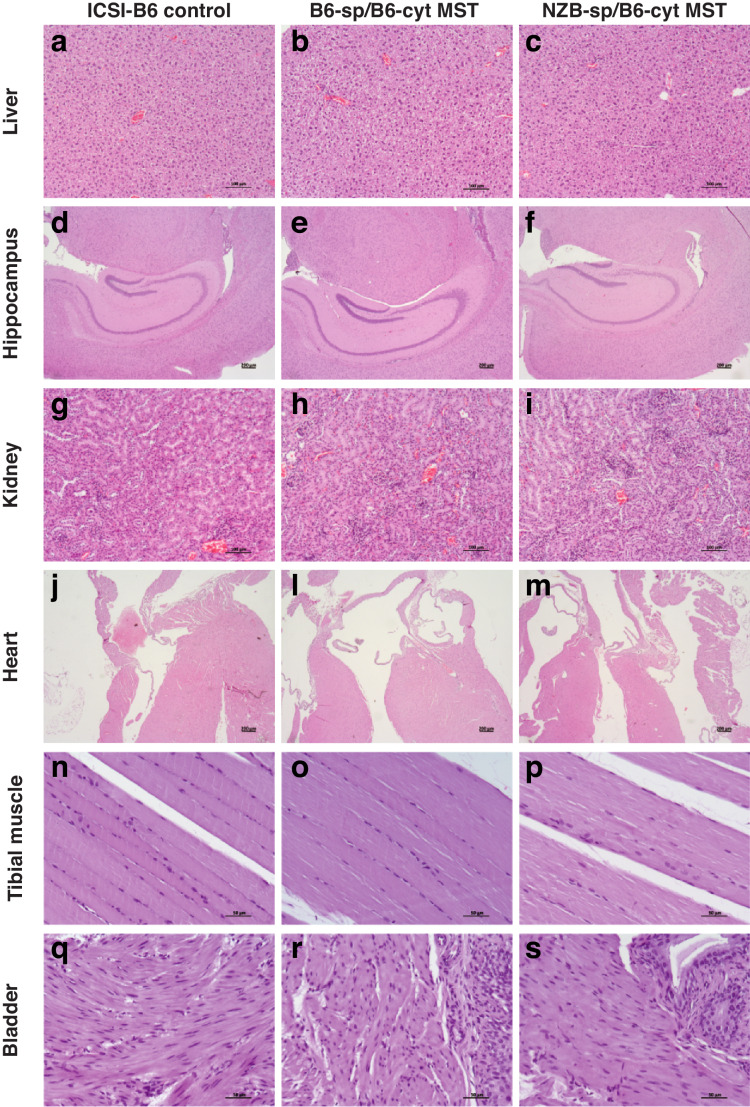
Hematoxylin and eosin (H and E) stained sections of adult mice generated from B6 ICSI control embryos, B6 reciprocal MST and NZB-sp/B6-cyt MST embryos.Representative images from liver (a-c), hippocampus (d-f), kidney cortex (g-i), heart (j-m), skeletal muscle from the tibia (n-p) and smooth muscle from the bladder (q-s). All analyzed sections showed the typical morphology of a healthy tissue.